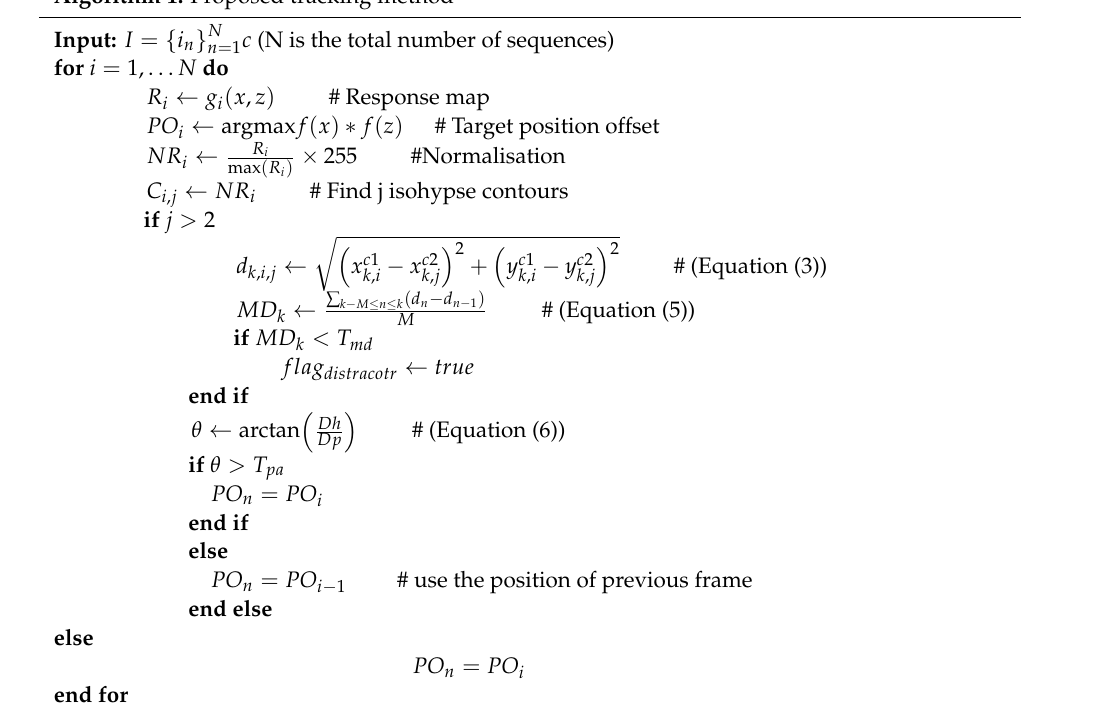
Figure 7. Peak angle plots of sequence ‘Basketball’ of OTB100.